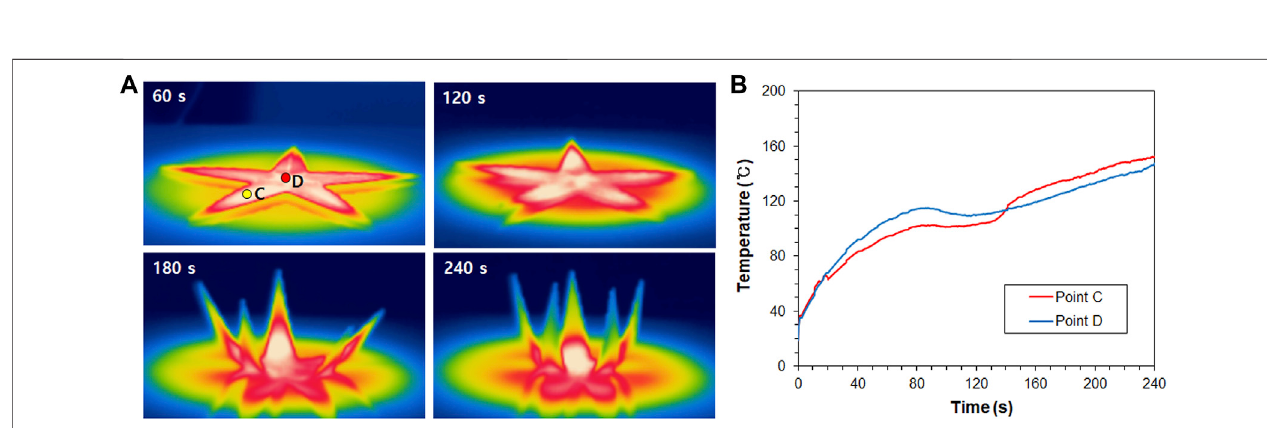
FIGURE6| Shape transformationsofthe2Dstar-shape plate (A) Additively manufactured star-shapespecimen (B) Mask design forlocal irradiation (unit: mm) (C) Deformed shape after global IR irradiation (D) Deformed shape after local IR irradiation. Here, IR irradiation time was set to 300 s for each case.